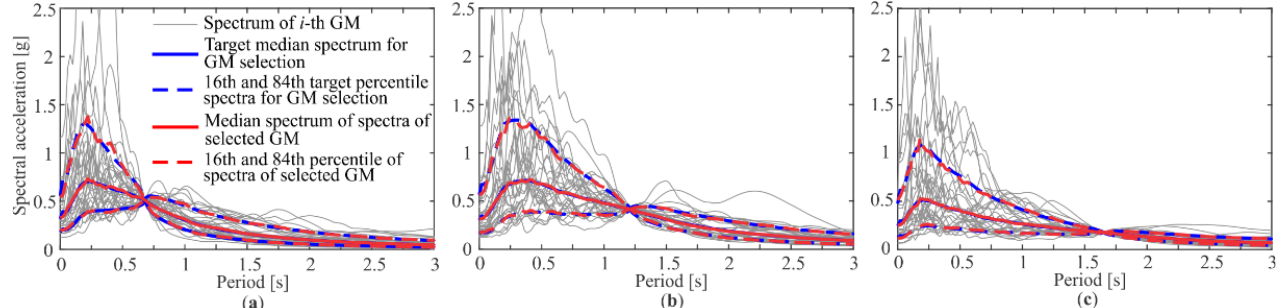
Figure 12. Target conditional acceleration spectra (median, 16th and 84th percentile), corresponding spectra of selected ground motions for an earthquake scenario based on S e,2475 , and acceleration spectra of each ground motion used for assessment of ( a ) 4-, ( b ) 8- and ( c ) 11-storey